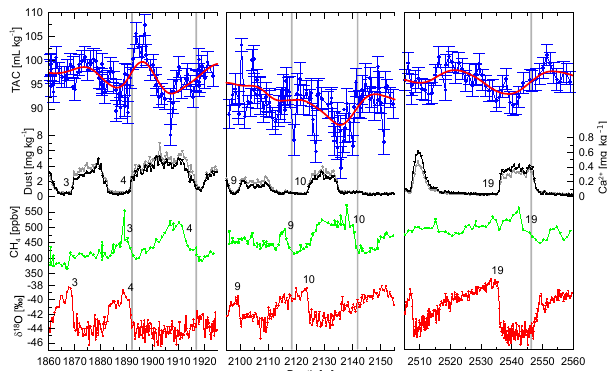
Figure 8. Zoom into DO events 3, 4, 9, 10 and 19 on depth scale. Blue: the TAC, including a spline with a 120m cutoff (thick red line). Black: the dust; grey: the Ca 2 + concentration (Ruth, 2007). Green: CH 4 ; red: the δ 18 O ice . Grey lines indicate the beginning of the DO events in CH 4 . More on the timing of TAC changes in Sect. 4.3.2 and in Figs. 9 and